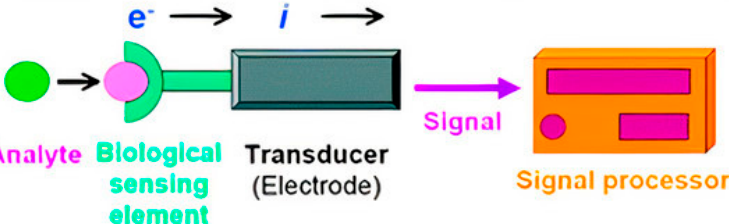
Figure 1. Biosensor’s basic design. Reprinted with permission from Huang, Y. et al. Disease-Related Detection with Electrochemical Biosensors: A Review. Sensors 17(10). Copyright (2017) MDPI [46].